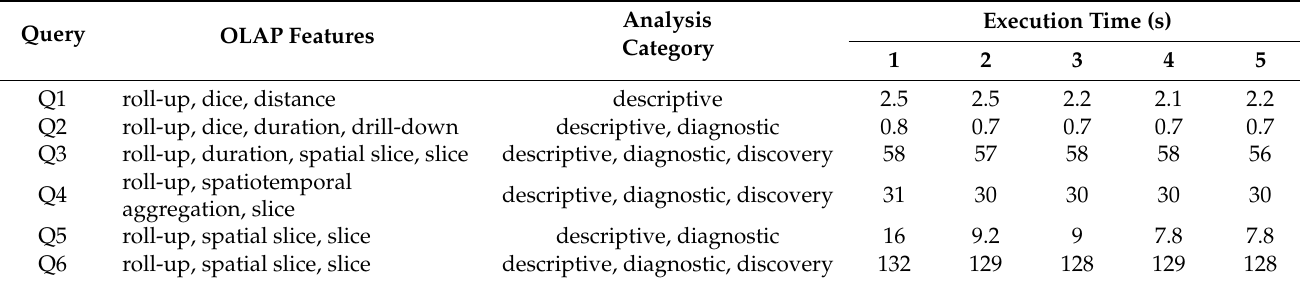
Table 3. Query Execution